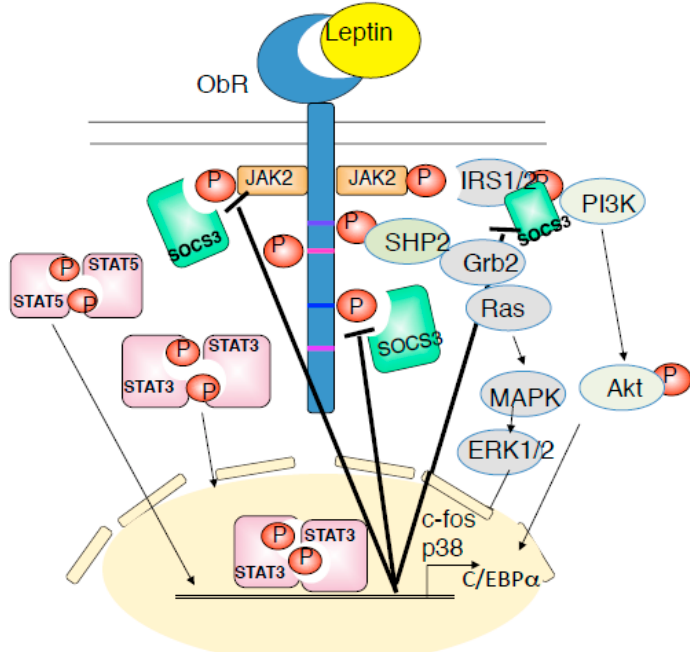
Figure 2. Leptin receptor signaling is mediated by JAK-STAT, PI3K-Akt, and SHP2-ERK pathway. Leptin binds to ObRb and activates JAK2, and induced to the phosphorylation of Tyr985, Tyr1077, and Tyr1138 of ObRb. PY-985, PY-1077, and PY-1138 bind to their downstream molecules and proceeds to phosphorylation of JAK2-STAT3, JAk2-STAT5, PI3K-IRS-Akt, SHP2-ERK pathways. These signaling are negatively regulated by SOCS3. Dysregulation of the leptin receptor signaling is involved in the onset of leptin resistance, inflammation and